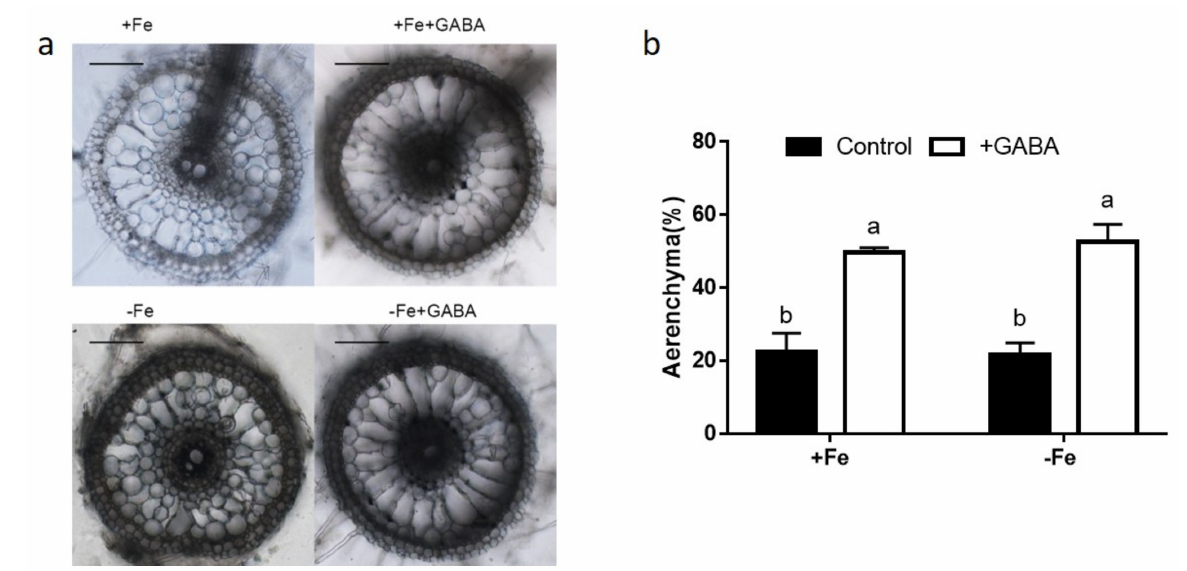
Figure 5. Effect of GABA on the formation of aerenchyma in the roots with or without Fe supply. ( a ) Root sections of seedlings treated with GABA with or without Fe. ( b ) GABA induced aerenchyma formation under conditions of both FS and FD. Three-day-old seedlings were treated with 0.5 mM GABA for one week. Free-hand sections were made 6–8 cm from root tips. Data are averages ( ± SD) from 5 sections. Bars = 100 µ